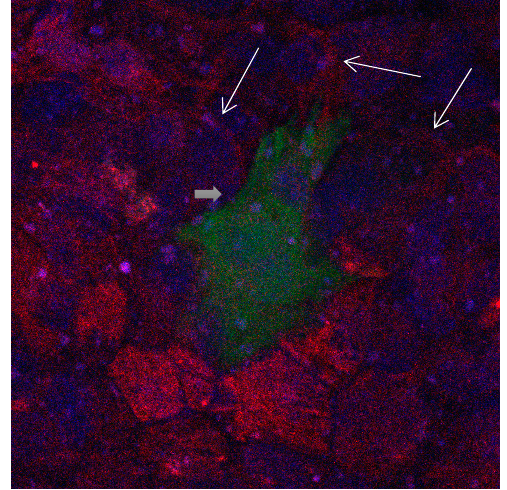
Figure 3. Cultures in a serum-containing medium, 9 days after passage: Immunofluorescence with anti-GFAP (glial fibrillary acidic protein) (red, secondary antibody: donkey anti-goat IgG Alexa Fluor 594), and with anti-Calbindin D28k (polyclonal antibody from the company SWANT) (green, secondary antibody: donkey anti-rabbit IgG Alexa Fluor 488); Nuclear staining with DAPI (4 ′ ,6-diamidino-2-phenylindole dihydrochloride) (blue). Confocal microscopy. Zoom = 4, numerous GFAP-positive and Calbindin D28k negative astrocytes (long arrows), in between 1 Calbindin D28k positive and GFAP-negative astrocyte (short arrows). − 3.35 × 10 − 3 to − 3.78 × 10 − 3 to − 3.47 × 10 − 3 to − 4.28 × 10 − 3 (Figure 4). But the percentage of GFAP positive